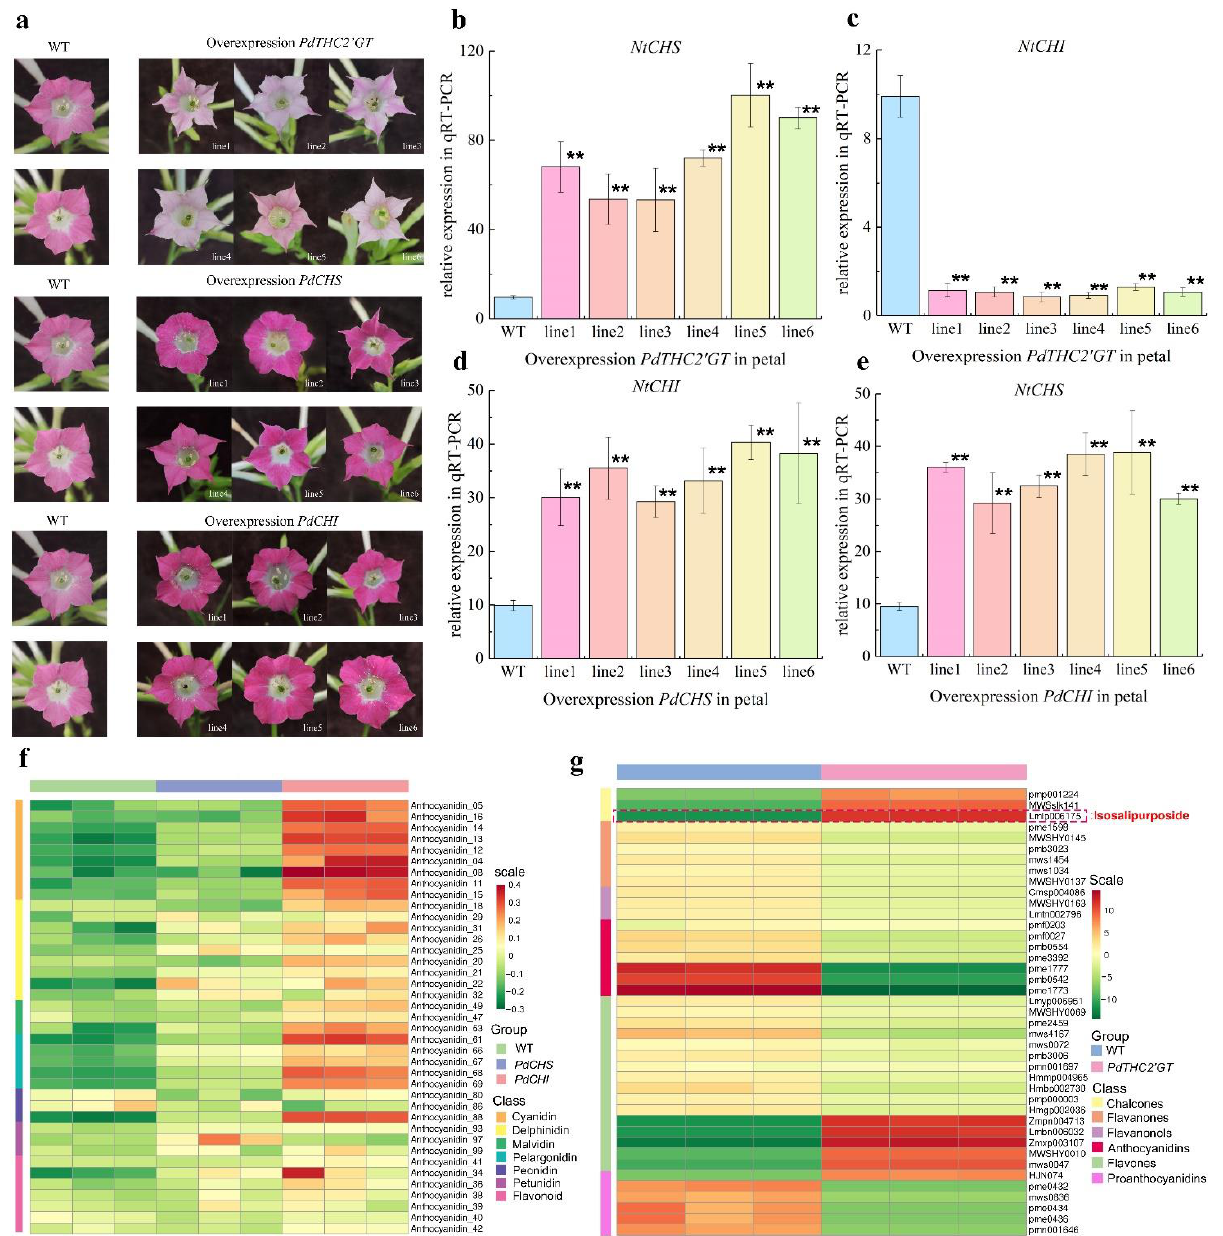
Figure 7. Functional analysis of tobacco lines overexpressing PdTHC2’GT , PdCHS, and PdCHI . ( a ) Phenotypic characterization of tobacco flowers between the wildtype group and transgenic lines. ( b ) After overexpression of PdTHC2’GT , the expression quantity of NtCHS in tobacco flowers changed. ( c ) After overexpression of PdTHC2’GT , the expression quantity of NtCHI in tobacco flowers changed. ( d ) After overexpression of PdCHS , the expression quantity of NtCHI in tobacco flowers changed. ( e ) After overexpression of PdCHI , the expression quantity of NtCHS in tobacco flowers changed. ( f ) Heatmap analysis of anthocyanin component. ( g ) Heatmap analysis of flavonoids component. The contents of ( f , g ) were log-transformed and used to generate a heatmap with the TBtools software package (v0.66443, Ziping Yang, Guangdong, China, open resources). The asterisks denote significant differences according to a one−way analysis of variance (ANOVA) (** p < 0.01). Qualitative and quantitative analyses of flavonoids in the transgenic tobacco lines and WT tobacco overexpressed with PdTHC2′GT were carried out. The qualitative and